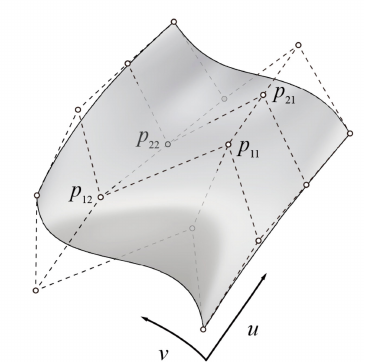
Figure 3. The modelling of the surface central part could be a ff ected by the shape parameters, so as to be close to or far from the virtual control